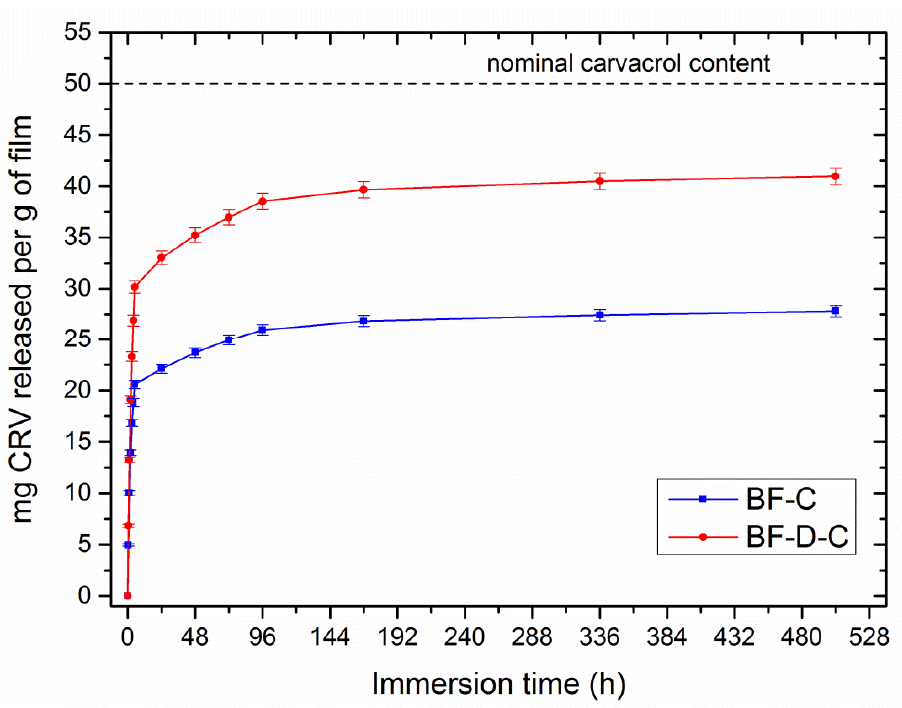
Figure 4. Amount of carvacrol released from BF-C and BF-D-C, expressed as milligrams of additive per one gram of film, plotted as a function of immersion time.